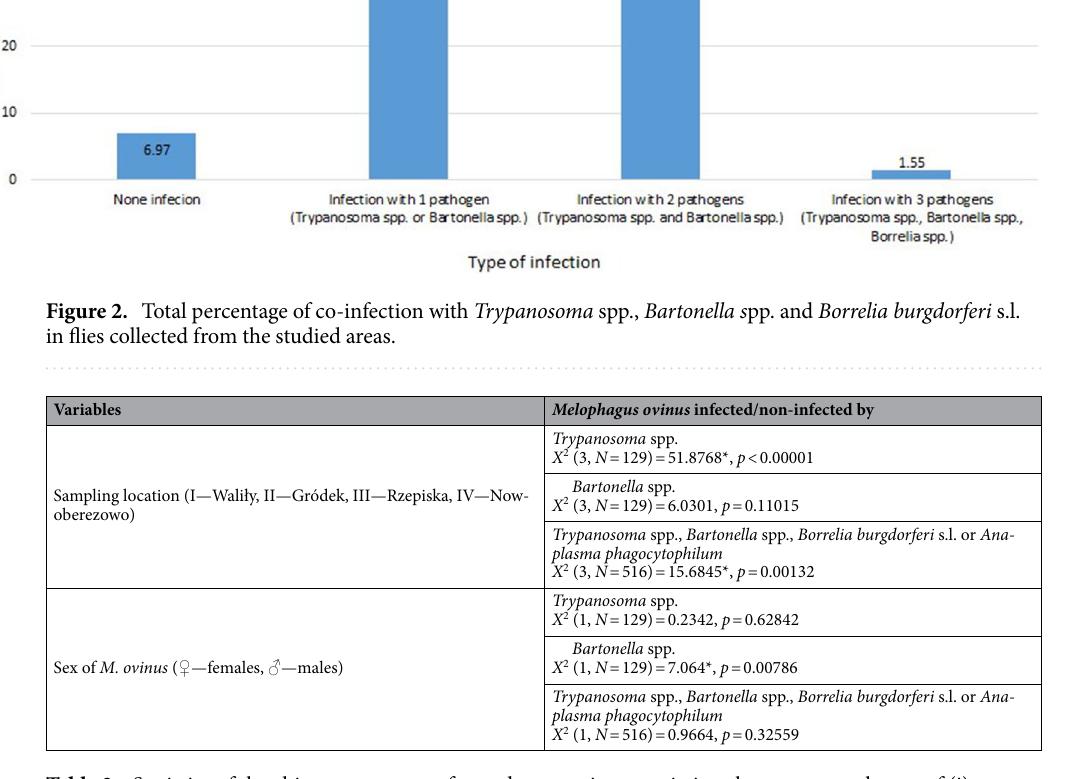
Table 2. Statistics of the chi-square tests performed to examine associations between prevalences of (i) Trypanosoma spp., (ii) Bartonella spp., (iii) Trypanosoma spp., Bartonella spp., Borrelia burgdorferi s.l. or Anaplasma phagocytophilum on Melophagus ovinus and (i) sampling location, (ii) sex of M. ovinus . *The result is significant at p ≤ 0.01.